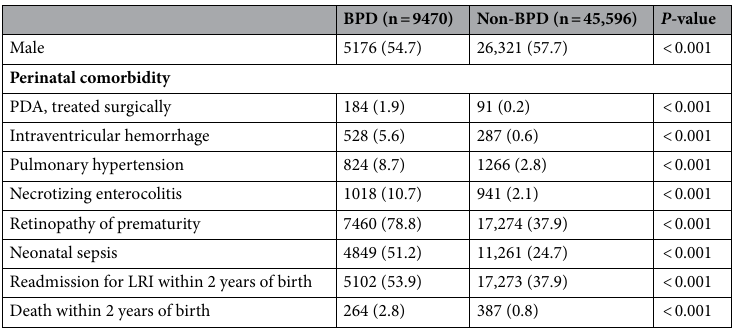
Table 1. Patient characteristics. Data are expressed as n (%). LRI lower respiratory illness, BPD bronchopulmonary dysplasia, PDA patent ductus arteriosus. P -value was calculated using Welch’s two-sample t test for continuous variables and Pearson’s Chi-square test with Yates’ continuity correction for categorical variables.